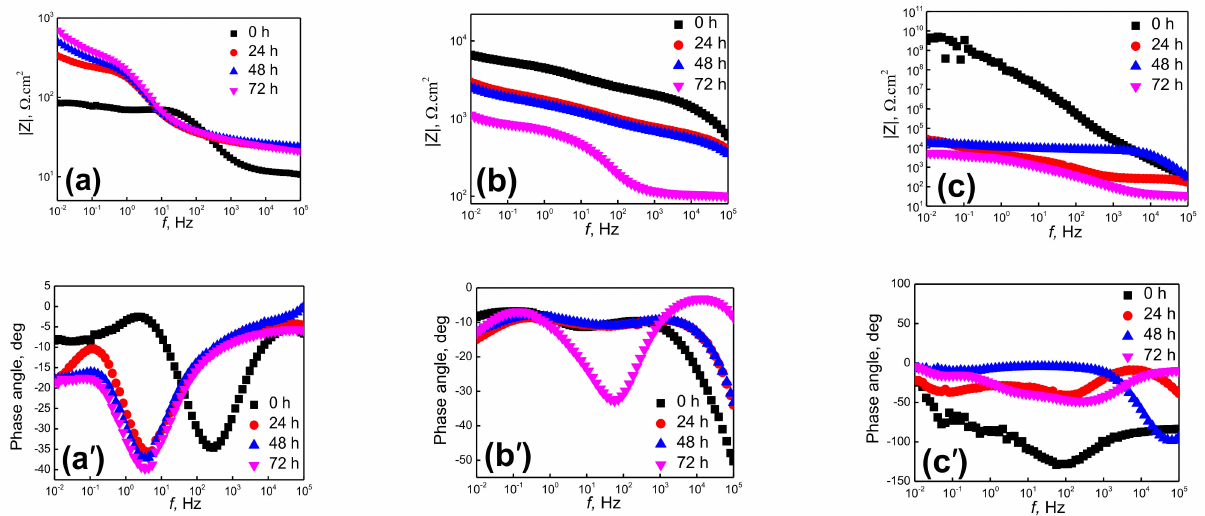
Figure 2. Bode plots of the EIS results for the rusted Q235B steel specimens at different corrosion times: ( a , a (cid:48) ) for the specimens #1; ( b , b (cid:48) ) for the specimens #2; ( c , c (cid:48) ) for the specimens